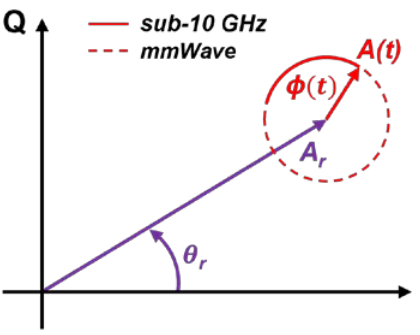
Figure 1. Graphical illustration in the complex plane of the baseband signal resulting from the cardiopulmonary activity and static